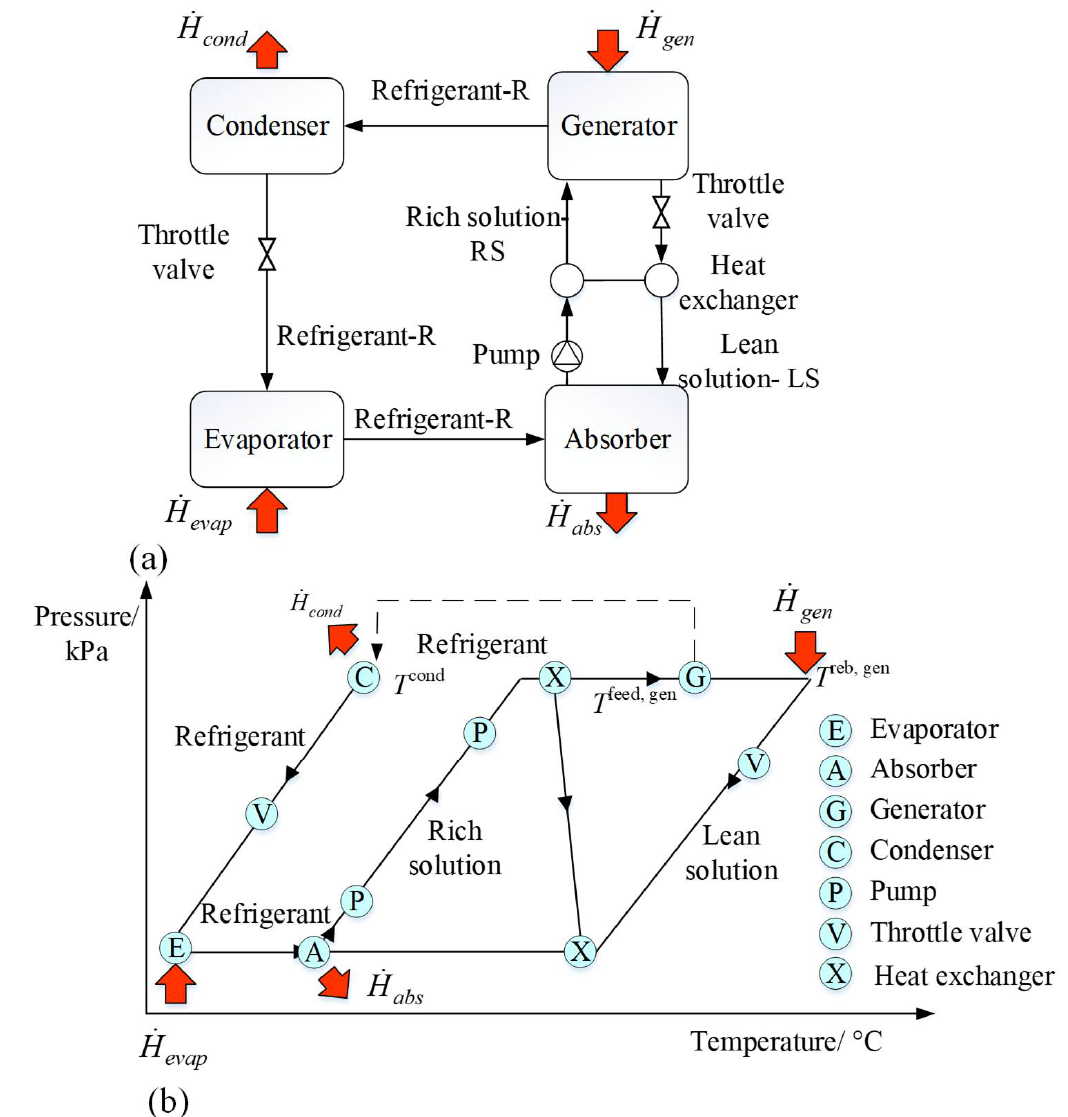
Figure 1. ( a ) Basic process scheme and ( b ) pressure-temperature diagram of AC.